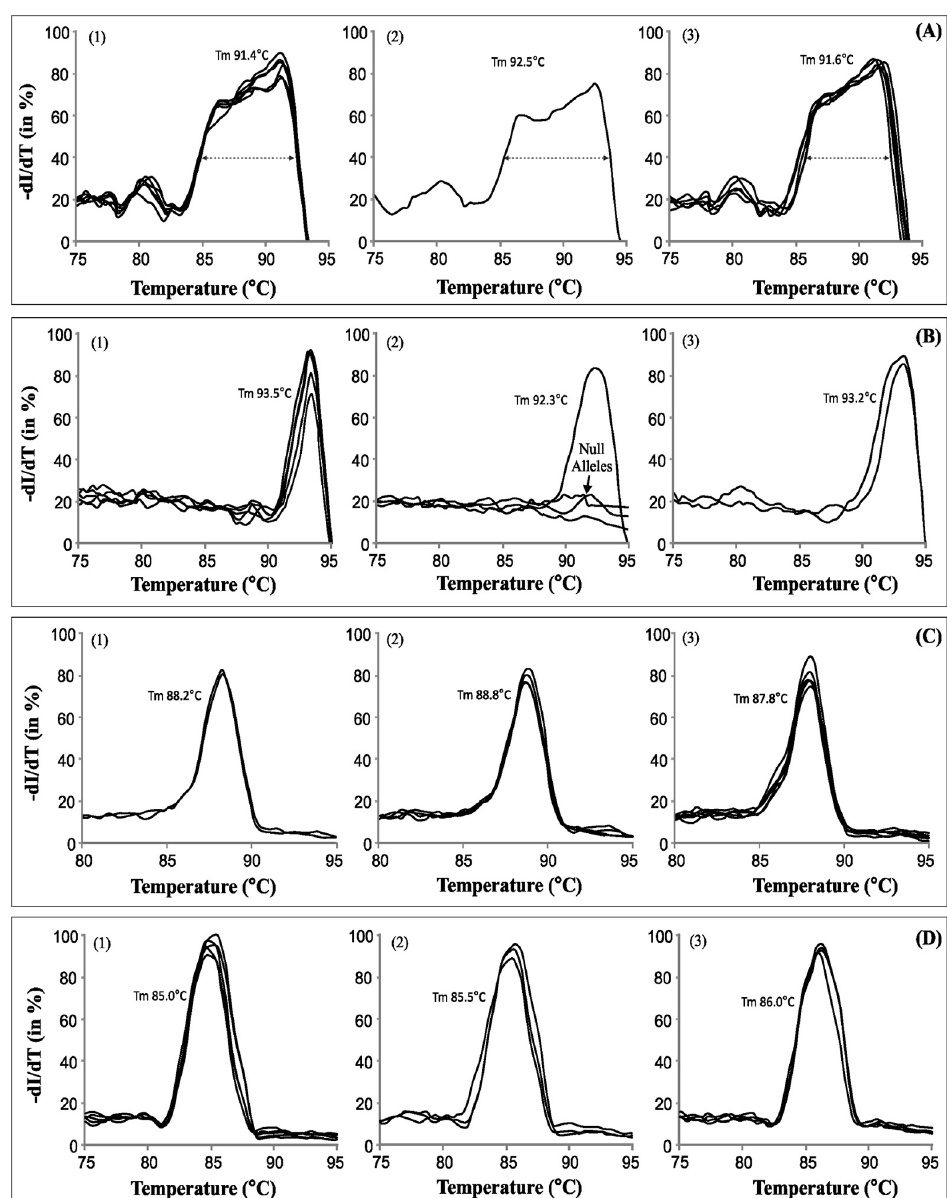
Fig 5. SYBR Green melt-profiles of STMS with low length polymorphism. SYBR Green melt-profiles of STMS marker alleles that showed low/no length polymorphism among twelve wheat genotypes: A) Xgwm 357–1A and B) Xgwm 232–1D. SYBR Green melt-profiles of STMS marker alleles that showed low/no length polymorphism among twelve rice genotypes: C) RM 154 and D) RM 431. Numbers indicate the profiles obtained for each STMS along with the corresponding Tm